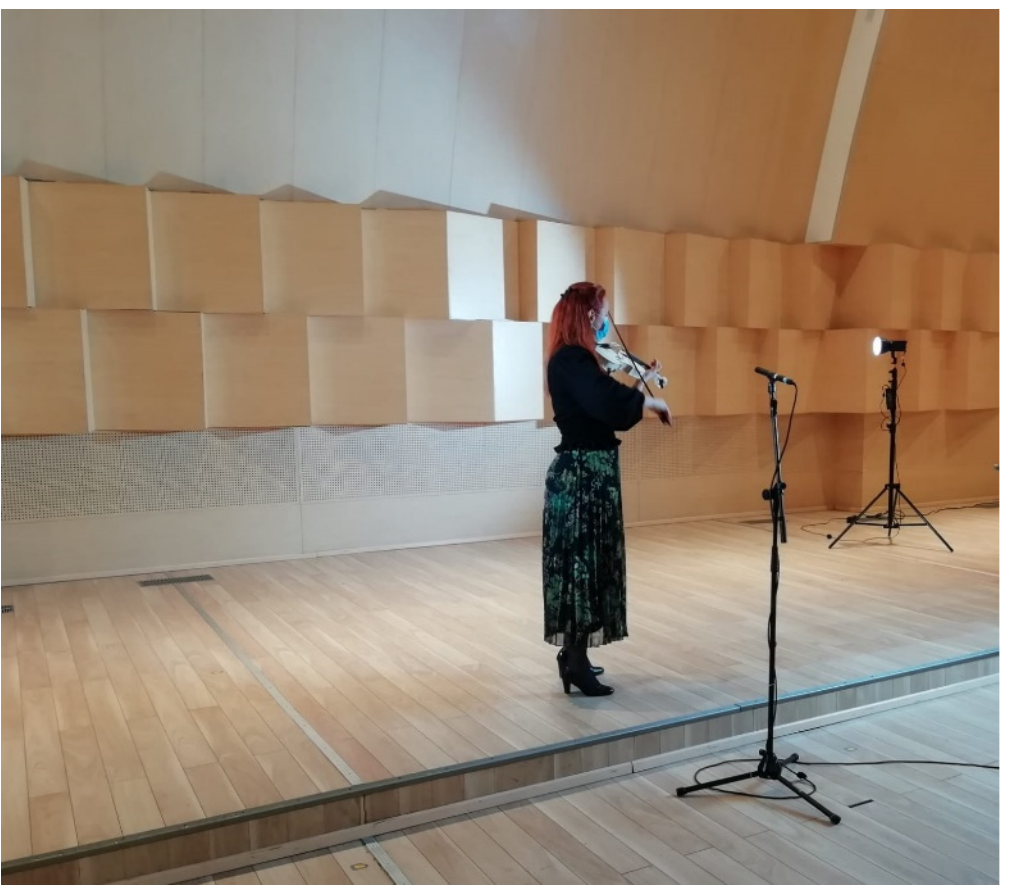
Figure 3. A sequence during the recordings of the professional violinist playing the first violin in the Brasov Philharmonic Orchestra.